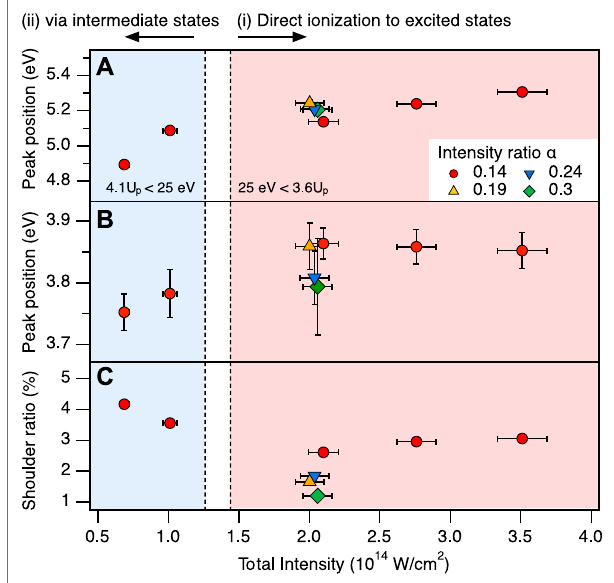
FIGURE 5 | Intensity dependence of the KER spectrum. (A) Position of the main peak in the OC + + S + channel as a function of the total laser fi eld intensity ( I ω +2 ω ). (B) Position of the shoulder peak in the OC + + S + channel. (C) RatiooftheshoulderpeakintheOC + +S + channel.Circles,triangles,up- side down triangles, and diamonds indicate the different intensity ratios of α = 0.14, 0.19, 0.24, and 0.3, respectively. Colored areas correspond to the intensity of(i)direct ionization tothe 1 3 Π state of OCS 2+ from the ground state of OCS + by electron recollision ( I ω +2 ω > 1.44 × 10 14 W/cm 2 ) and (ii) indirect excitationviatheelectronicallyexcitedstatesofOCS +